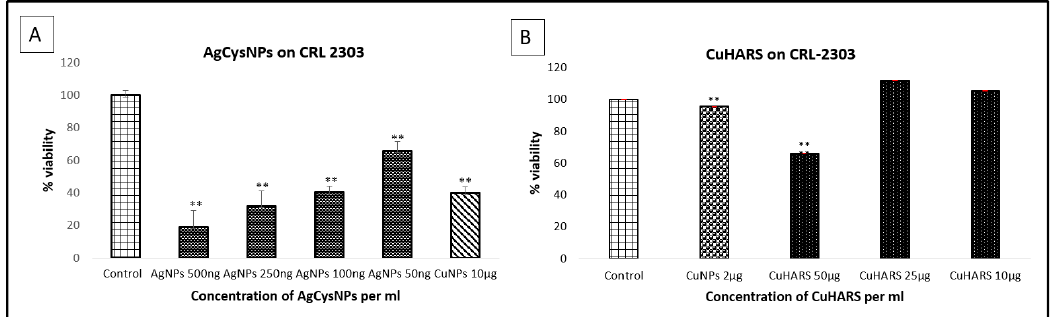
Figure 9. Toxicity testing of nanomaterials added on incubated cells. CRL 2303 glioma cells at 40,000 per well were treated with AgCysNPs or CuNPs (Panel A ), at the indicated concentrations, or CuHARS (Panel B ), and tested for viability. CRL 2303 cells at 40,000 per well were grown in vitro for two days and then treated with either AgCysNPs (Panel A ), or CuHARS (Panel B ). Upon termination after 24 h post treatment, an MTT assay was carried out to test for cellular metabolic activity. Data for each condition are the average of n = 2 wells with standard deviation indicated. Data represent multiple platings of each cell type tested, with ** denoting p < 0.01 compared to control conditions. Y -axis = Viability normalized to % of controls (column 1 values). For evaluation of AgCysNPs (Panel A ), the right-most column = addition of CuNPs for comparative purposes at 10,000 ng/mL. Controls were the untreated cells in both panels.